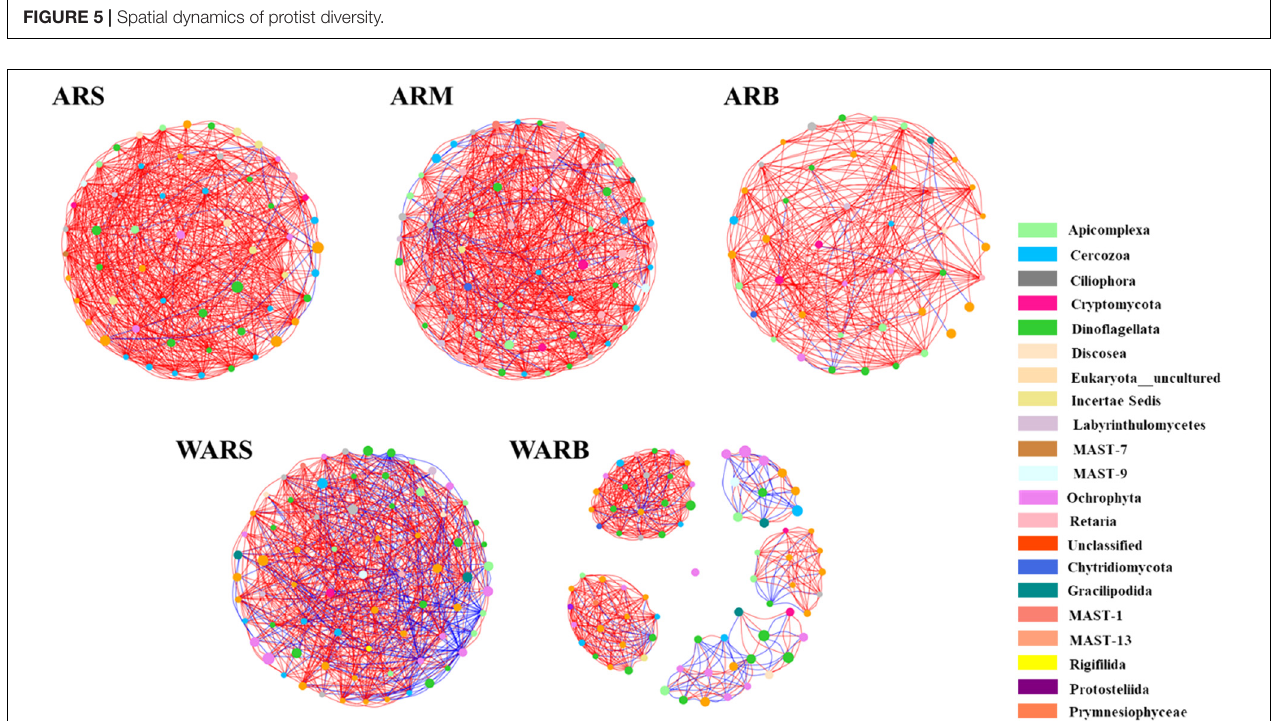
FIGURE 6 | Co-occurrence networks of protist communities. Networks are colored by phylum. The size of the node indicates the abundance of the corresponding OTU. A red line indicates a positive interaction between two individual nodes, while a blue line indicates a negative interaction.